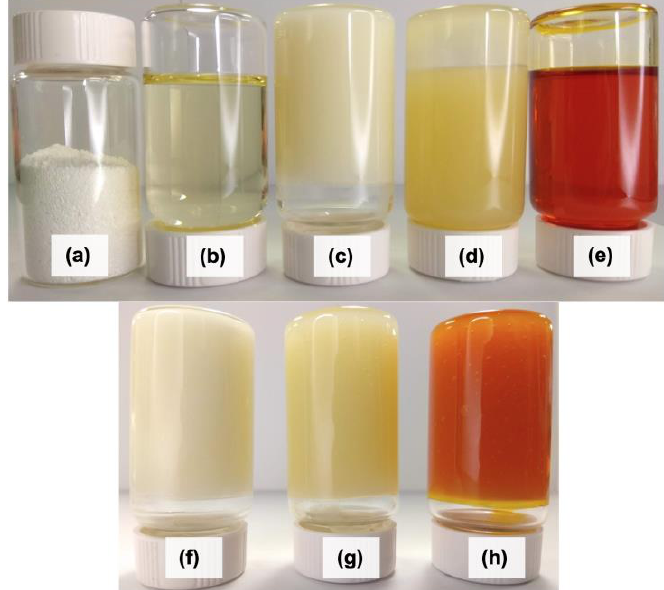
Figure 1. Appearance of oils, emulsifier and produced shortenings. ( a ) T130 emulsifier, ( b ) HOSO, ( c ) TPO, ( d ) HOPO, ( e ) HORO, ( f ) TPO shortening, ( g ) HOPO shortening, ( h ) HORO shortening.